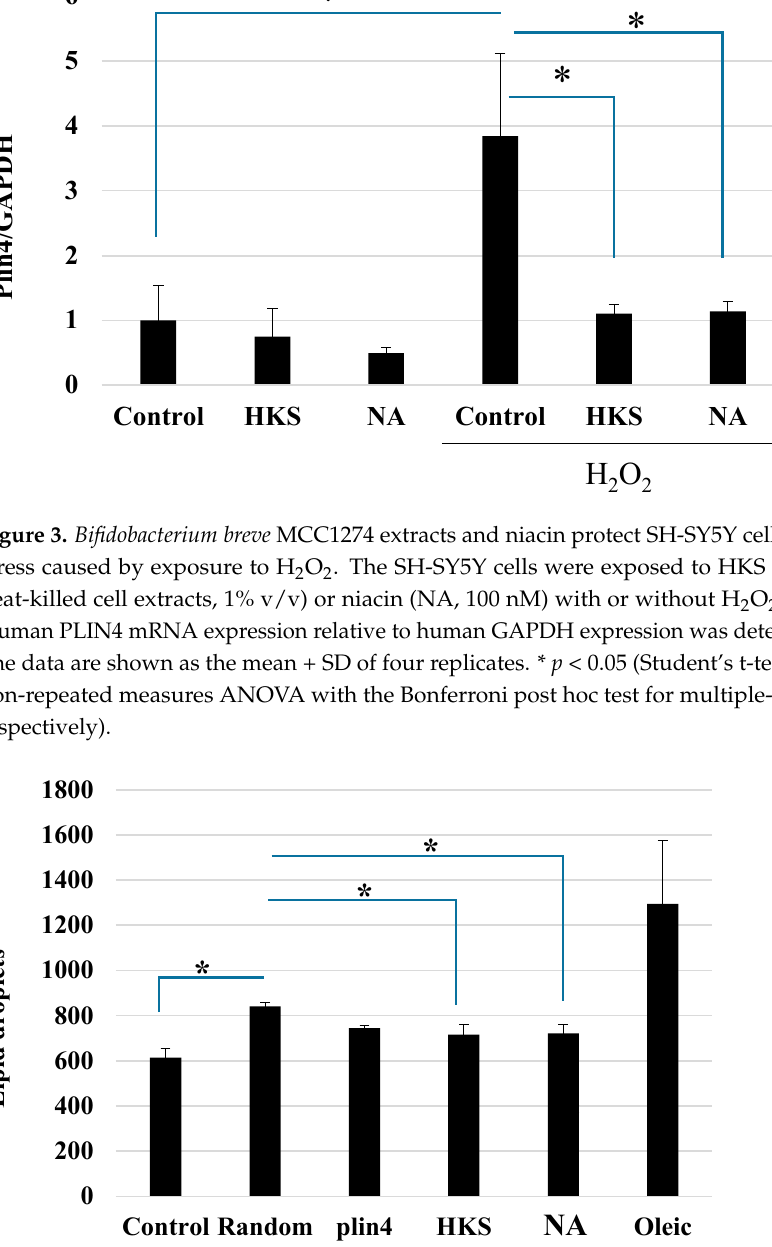
Figure 3. Bi fi dobacterium breve MCC1274 extracts and niacin protect SH-SY5Y cells against oxidative stress caused by exposure to H 2 O 2 . The SH-SY5Y cells were exposed to HKS ( B. breve MCC1274 heat- killed cell extracts, 1% v/v) or niacin (NA, 100 nM) with or without H 2 O 2 (200 µM) for 24 h. Human PLIN4 mRNA expression relative to human GAPDH expression was determined by RT-PCR. The data are shown as the mean + SD of four replicates. * p < 0.05 (Student’s t-test for two-group or non- repeated measures ANOVA with the Bonferroni post hoc test for multiple-group comparison, re- spectively).